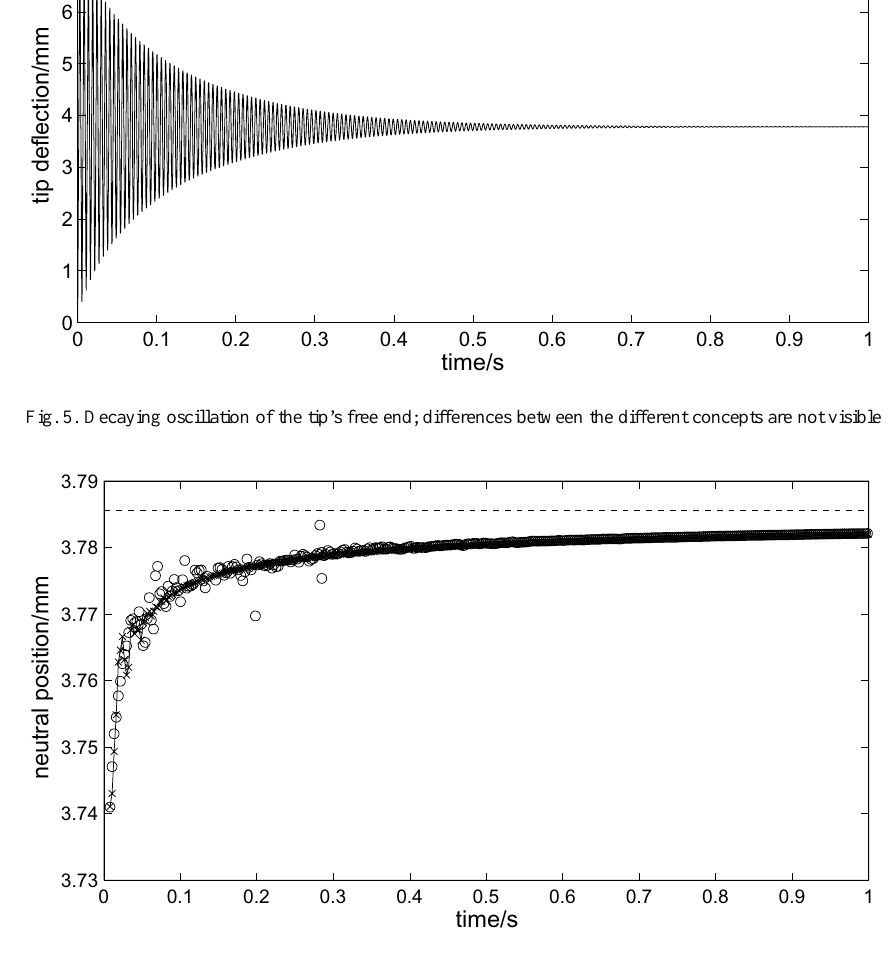
Fig. 6. Calculated creep of the neutral position; reference calculation (solid), concept A (crosses), concept B (circles). = 3 . 786 mm, see dashed line in Fig. 6 lim u np = E 0 A t →∞